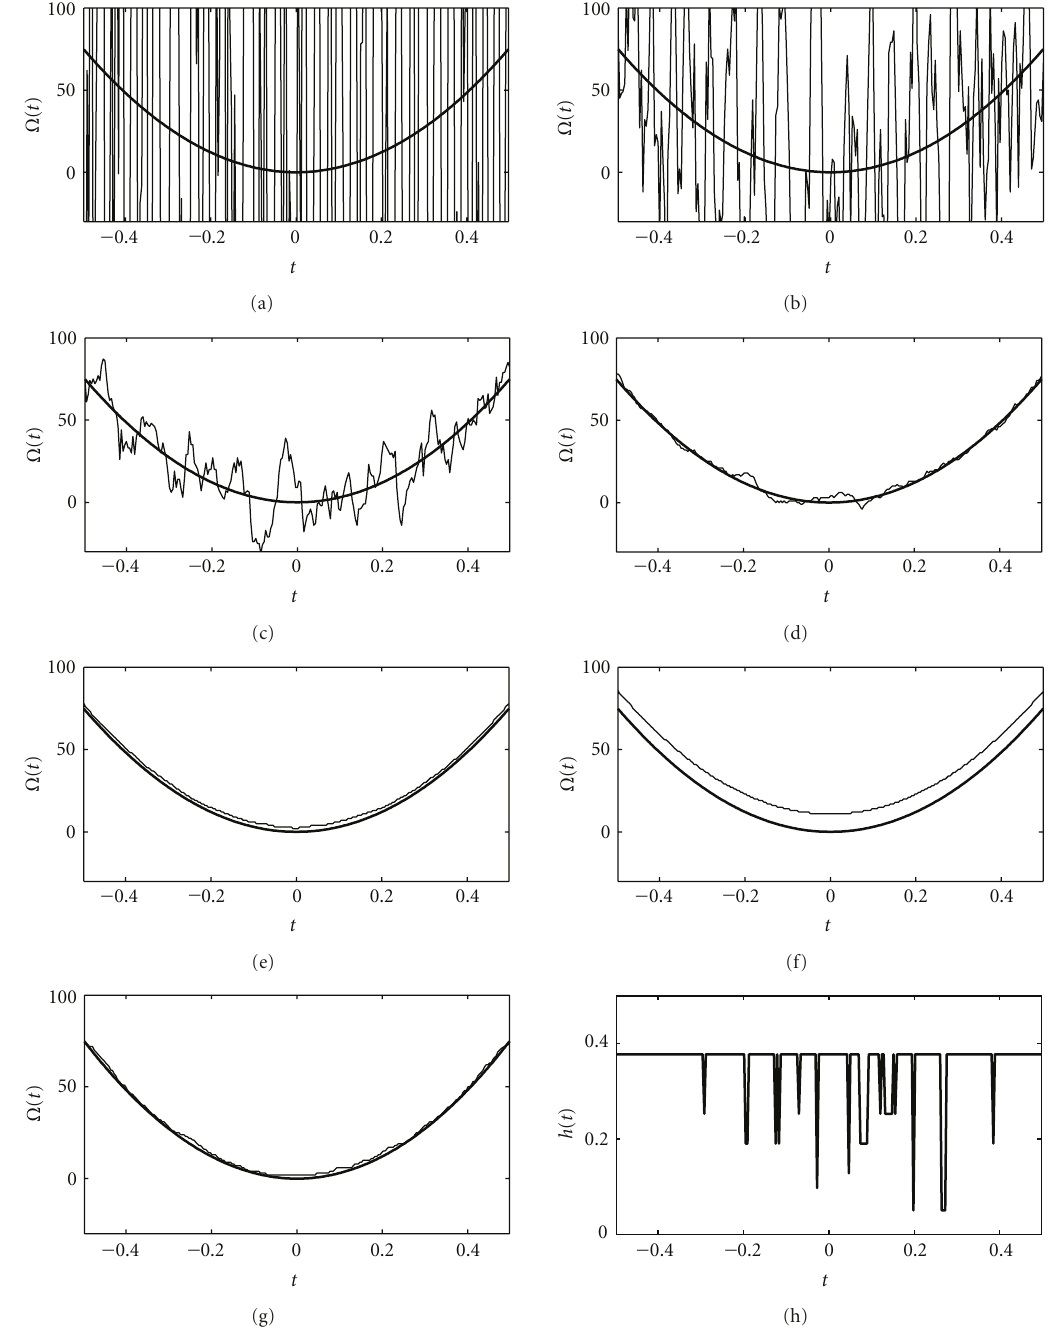
Figure 3: Chirp-rate estimation for test signal 2: (a) Fixed window N = 9 samples ( h = 9 / 257); (b) Fixed window N = 17 samples ( h = 17 / 257); (c) Fixed window N = 33 samples ( h = 33 / 257); (d) Fixed window N = 65 samples ( h = 65 / 257); (e) Fixed window N = 129 samples ( h = 129 / 257); (f) Fixed window N = 257 samples ( h = 1); (g) Estimator with adaptive window width; (h) Adaptive window width.